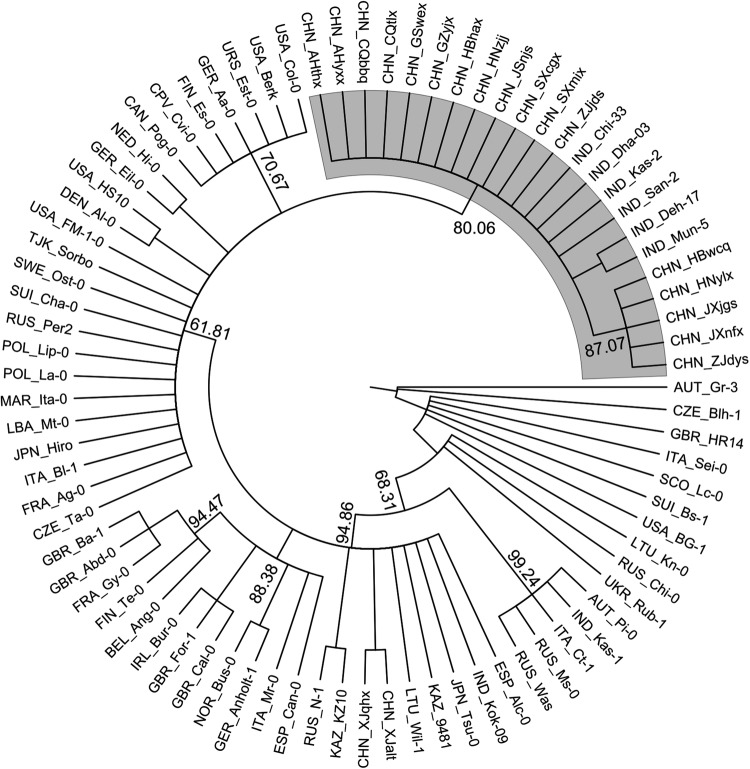
Neighbour-joining bootstrap consensus tree of west Himalaya and the rest of the world accessions. The tree was constructed using the concatenated data set of 11 chloroplast markers and following the indel coding method, MCIC. Numbers at the nodes are bootstrap values as percentages of 1000 replicates. Grey-shaded clade represents Cluster I, and the rest of the accessions are part of Cluster II.